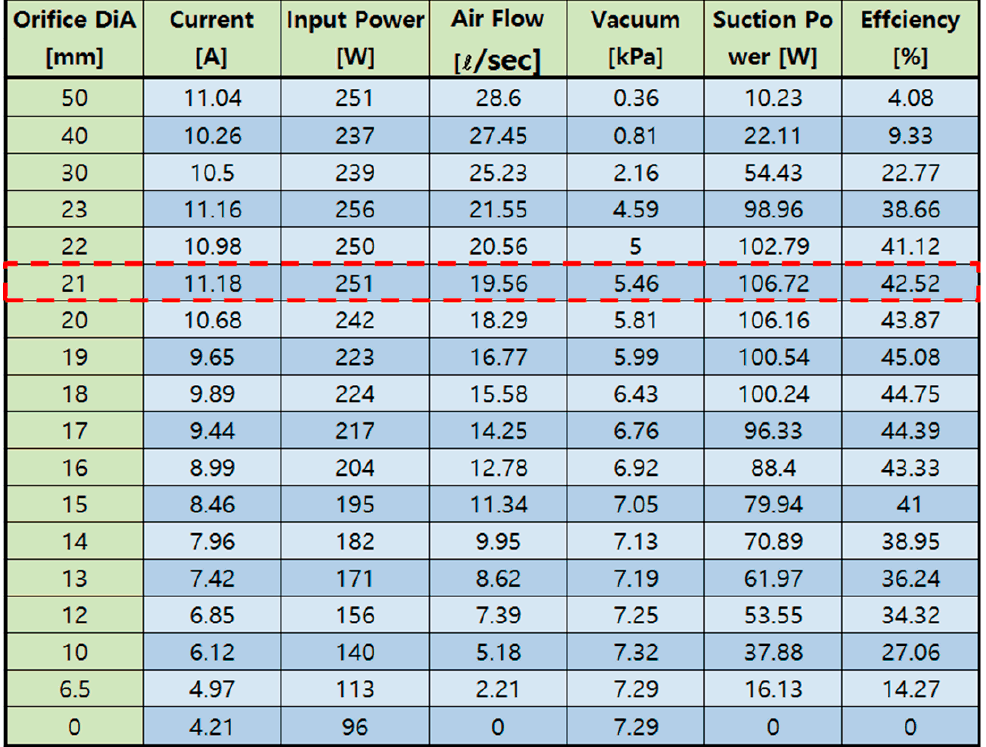
Figure 25. Prototype two ‐ phase 4/2 pole SRM suction power test data.